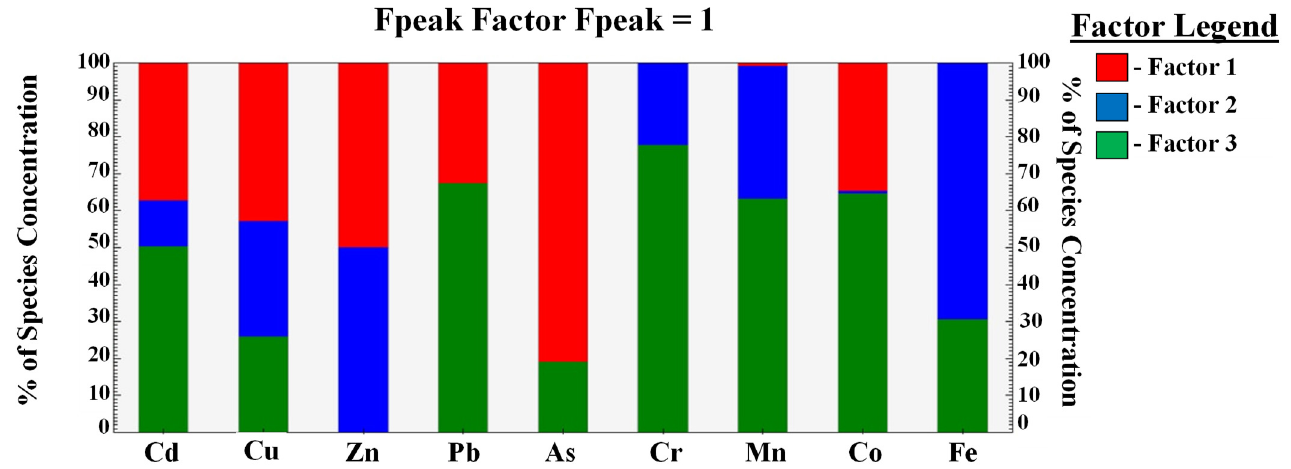
Figure 6. Factor fi ngerprints of metals resulting from the PMF model. Figure 6. Factor fingerprints of metals resulting from the PMF